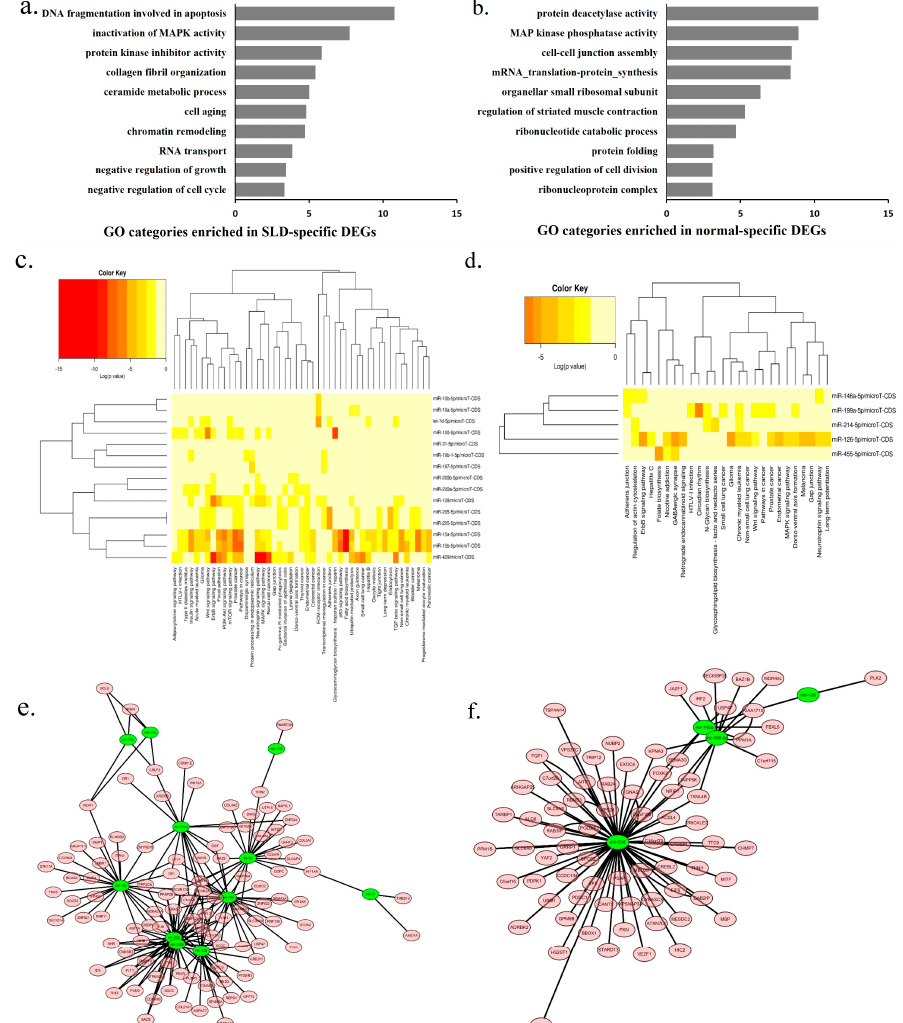
Figure 5. Functional and network analysis of the strain-specific period DEGs and DEMs. ( a ) GO enrichment for the SLD-specific period DEGs. The y -axis represents GO terms and the x -axis represents fold enrichment (with p value < 0.05); ( b ) GO enrichment for the normal-specific period DEGs. The y -axis represents GO terms and the x -axis represents fold enrichment (with p value <0.05); ( c ) Heat map of putative pathways of SLD-specific period DEMs by DIANA miRPath analysis; ( d ) Heat map of putative pathways of normal-specific period DEMs by DIANA miRPath analysis; ( e ) Interaction network of SLD-specific DEGs and DEMs between E14 and 7w based on MAGIA and Cytoscape software. Green circles represent SLD-specific DEMs and pink circles represent SLD-specific DEGs. Length edges are log p value; ( f ) Interaction network of normal-specific DEGs and DEMs between E14 and 7w based on MAGIA and Cytoscape software. Green circles represent normal-specific DEMs and pink circles represented normal-specific DEGs. Length edges are log p value.